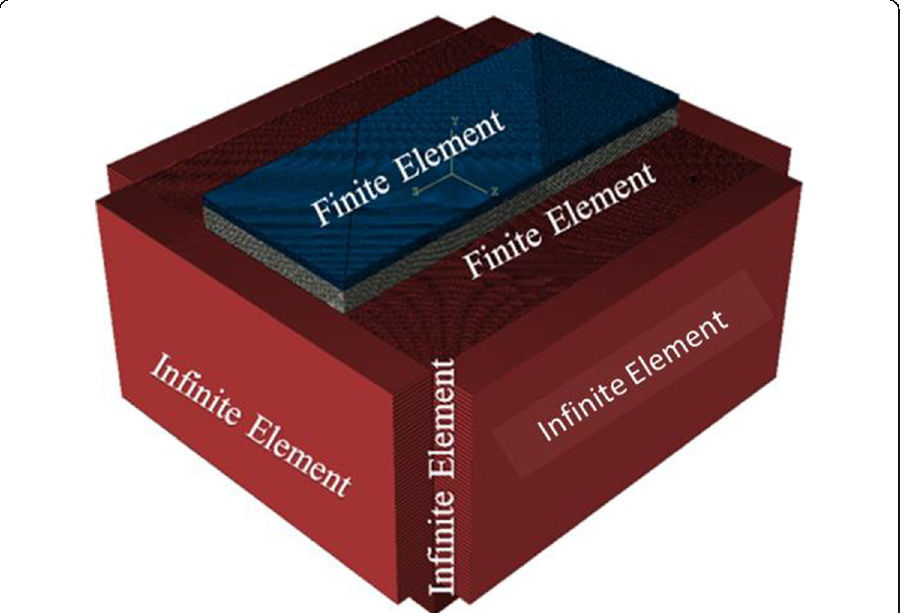
Fig. 10 Slab track model in